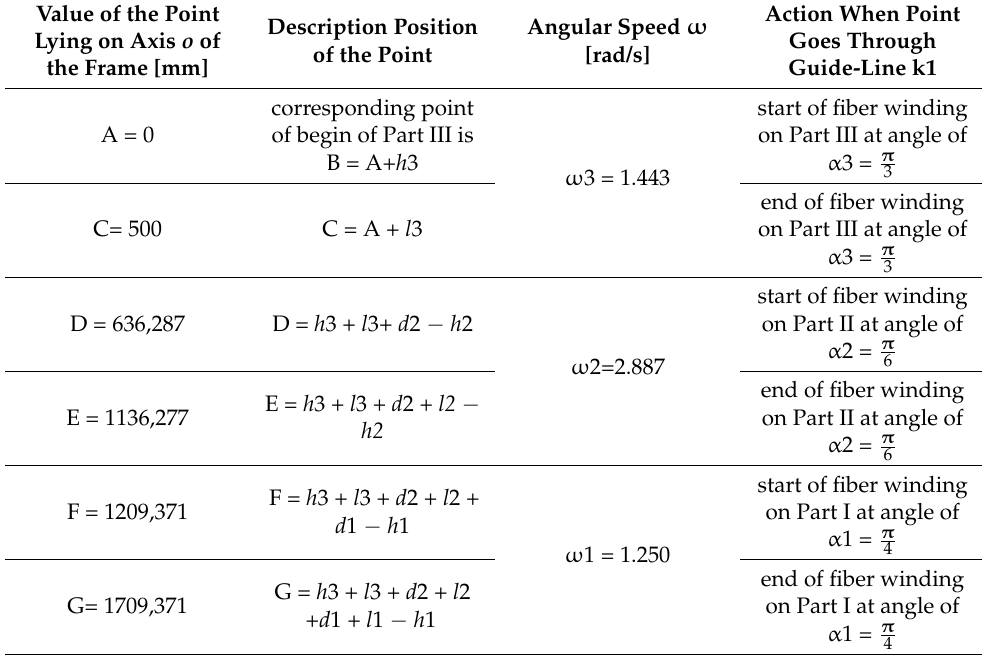
Table 4. An overview of the locations of the starts and ends of fiber winding on the frame by guide-line k 1 at the required